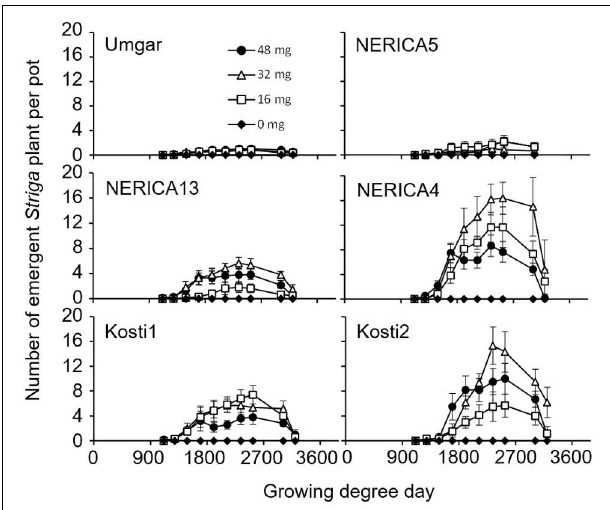
FIGURE 6 | Number of emergent S. hermonthica plants per pots planted with rice. Umgar, NERICA5, NERICA13, NERICA4, Kosti1, and Kosti2 were used in the third pot experiment. The Striga seeds (0, 16, 32, and 48 mg) were mixed into top 5 cm of soil in each pot. Bars indicate standard errors of each mean value of six replications.